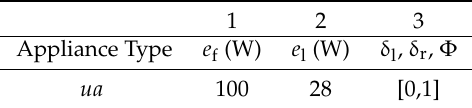
Table 6. Parameters of ua appliances